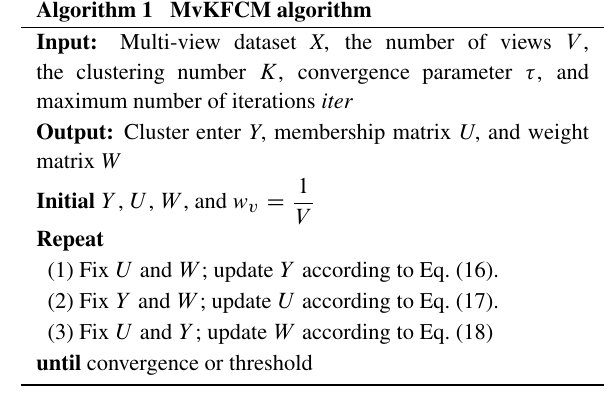
Fig. 3 Condition recognition mode based on